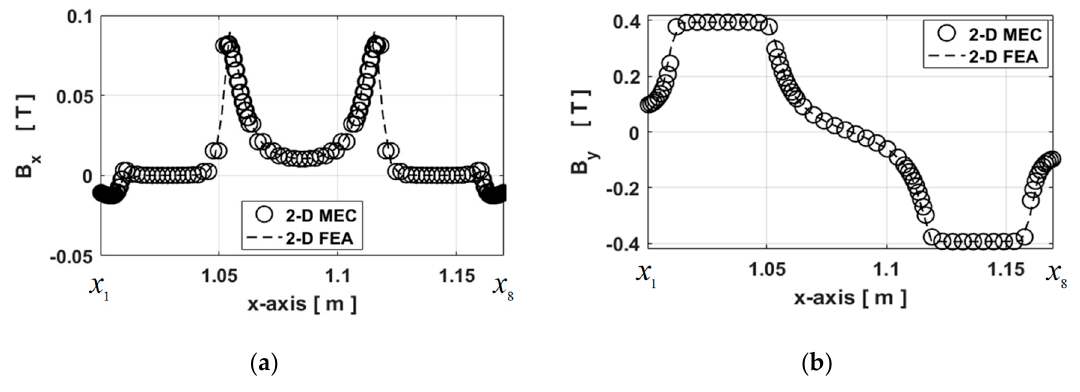
Figure 7. Waveform of B for Path m1 with A = y-component.